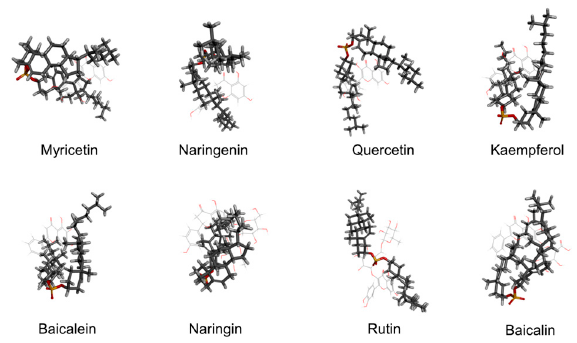
Figure 5 . Superimposition of the computed poses for flavonoids with cholesteryl sulfate. Figure 5. Superimposition of the computed poses for flavonoids with cholesteryl